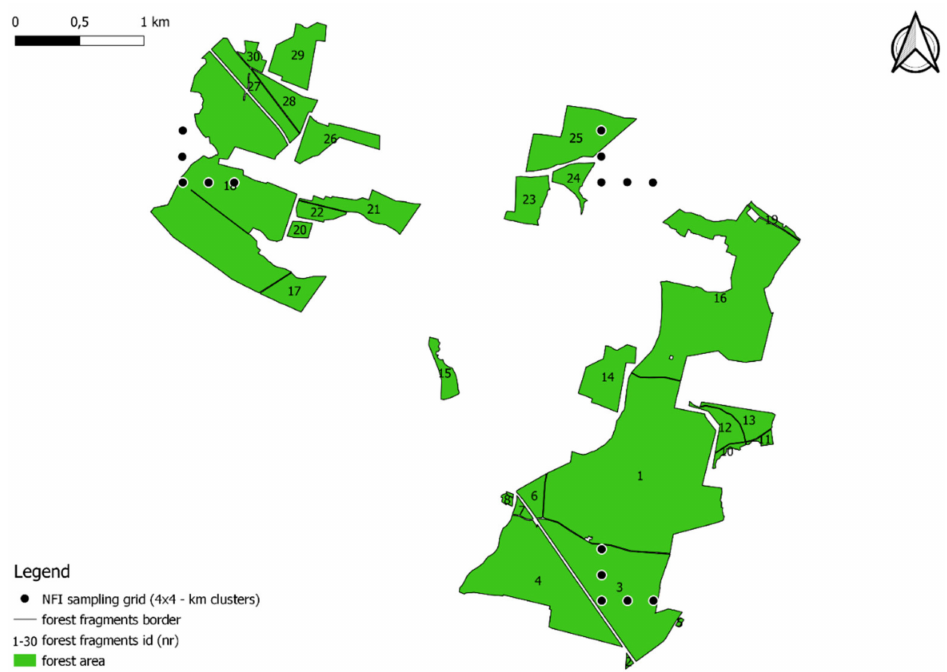
Figure 1. An example scheme showing distribution of NFI plots against the background of forest fragments. Data from field measurements conducted during the third NFI cycle (years 2015–2019) were used for the analysis. Since the vast majority of forests in Poland are managed forests, areas under strict nature conservation were excluded from the analysis. Uniformly managed stands were selected as study material. Only NFI sample plots with tree canopy (stands) were considered. Plots without trees, e.g., temporarily unstocked due to clear- cutting as part of forest management, or those that were located along forest roads,